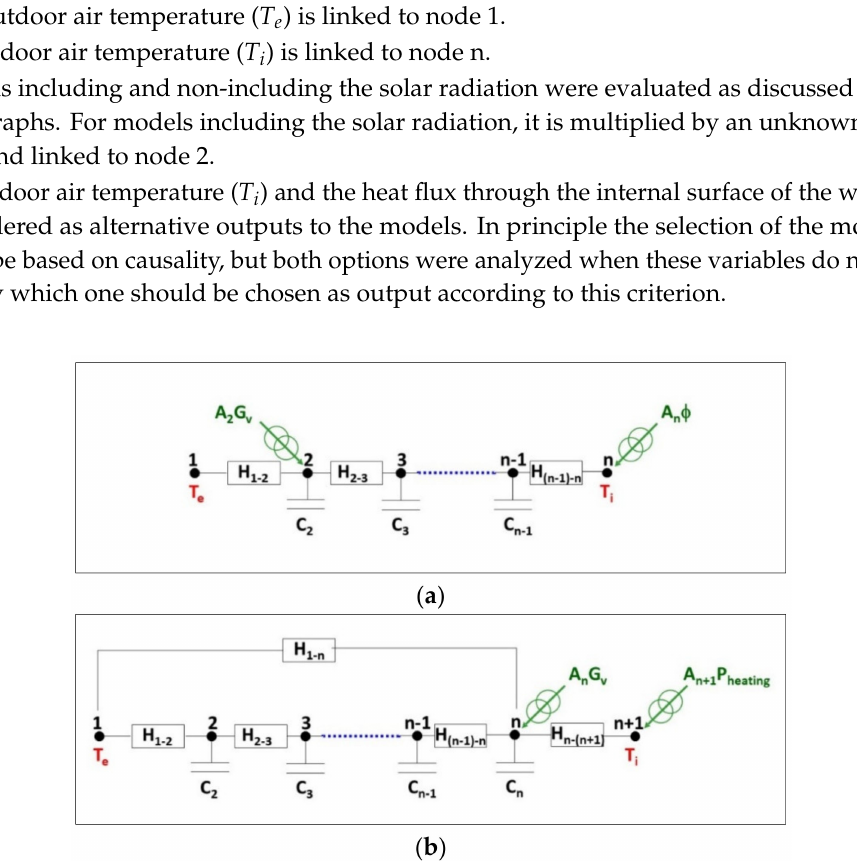
Figure 3. RC models considered for the analysis. The blue dots indicate the di ff erent candidate models adding resistances and capacitances where n is 3 to 7. ( a ) One-dimensional analysis of the opaque walls. With A n fixed to 1, and C 1 = C n = 0. ( b ) Three-dimensional analysis of the whole building. With A n identified by the model and A n + 1 fixed to 1, and C 1 = C n + 1 =